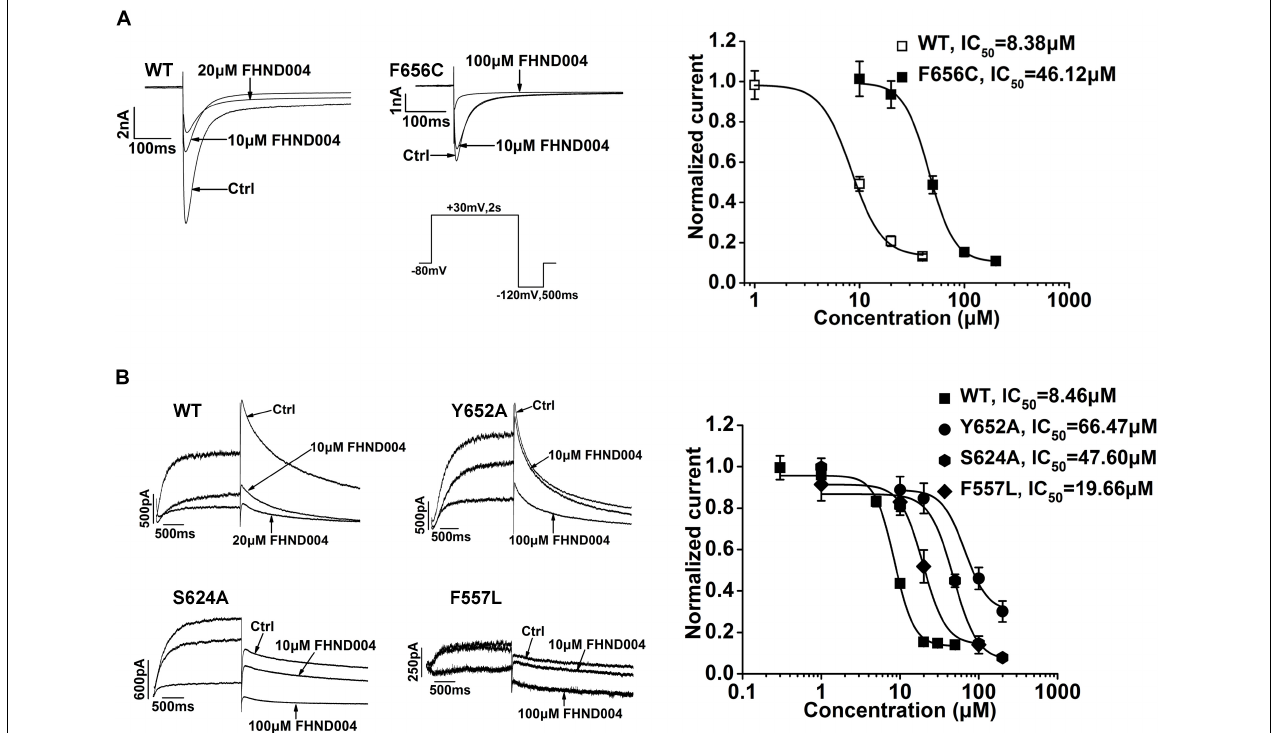
FIGURE 6 | Molecular determinants of hERG channel block by FHND004. (A) Current traces of WT-hERG and F656C in high [K + ] e (94 mM) bath solution before and after the application of FHND004 with the protocol used to elicit the inward tail current shown in the inset and concentration–response relationships fitted with logistic equation for block of WT- and F656C-hERG inward tail current by FHND004 ( n ≥ 5 per data point), and the slope factors are 3.00 and 3.61, respectively. (B) Current traces of WT-hERG, and Y652A, S624A, and F557L mutations before and after the application of FHND004 and concentration–response relationships fitted with logistic equation for block of WT- and Y652A-, S624A-, and F557L-hERG tail currents by FHND004 ( n ≥ 6 per data point), and the slope factors are 3.50 ± 6.67, 3.00 ± 1.87, 2.86 ± 1.63, and 3.00 ± 1.39,